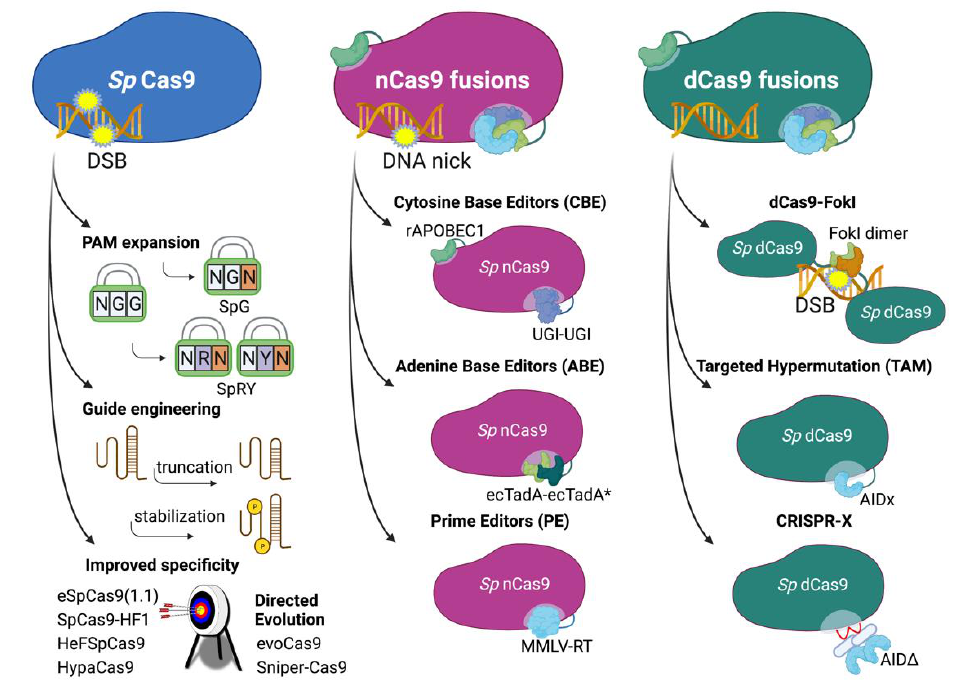
Figure 3. Engineering Cas9 to expand the range of applications and precision of genome editing. Streptococcus pyogenes ( Sp ) Cas9 has been modified to reduce target requirements and increase specificity. Partially inactivated (nCas9) and fully inactivated (dCas9) variants have been used to target DNA-modifying activities to specific genomic loci.